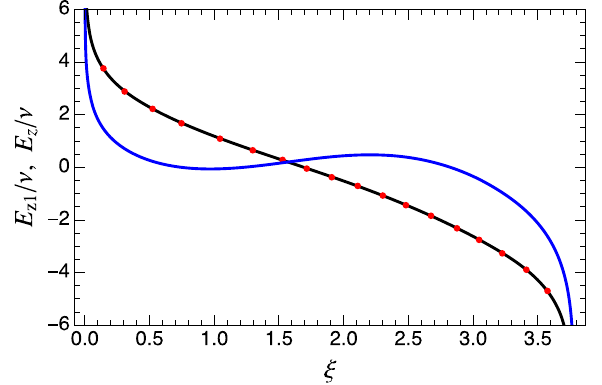
FIG. 6. Electric field component E z 1 (blue line) and the total field E z (black line) on the axis of the bubble. The plot of E z = ν corresponds to ν ¼ 0 . 1 . The fields are normalized by parameter ν